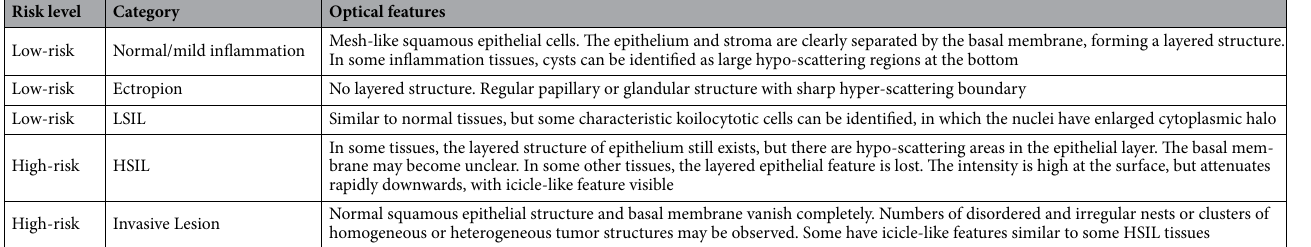
Table 2. Optical features of different cervical lesions on OCT.